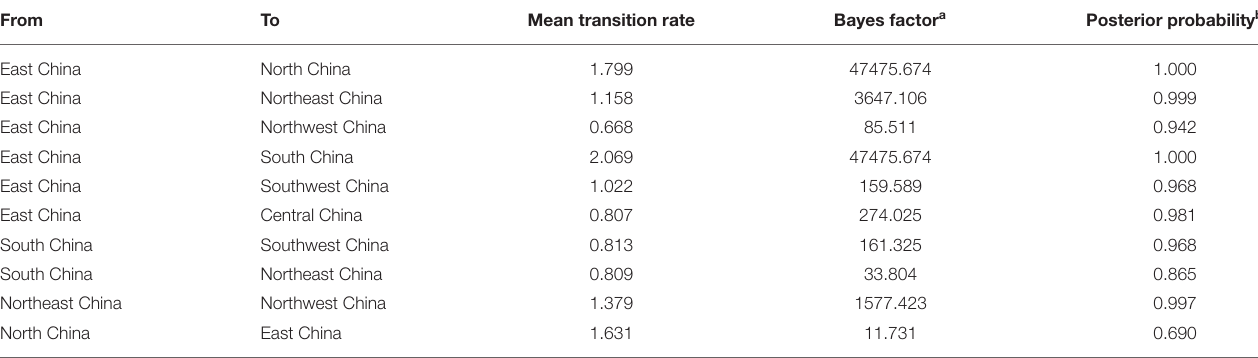
TABLE 3 | Statistically supported migration rates of PPMV-1 isolates circulating in China estimated from the F gene. From To Mean transition rate Bayes factor a